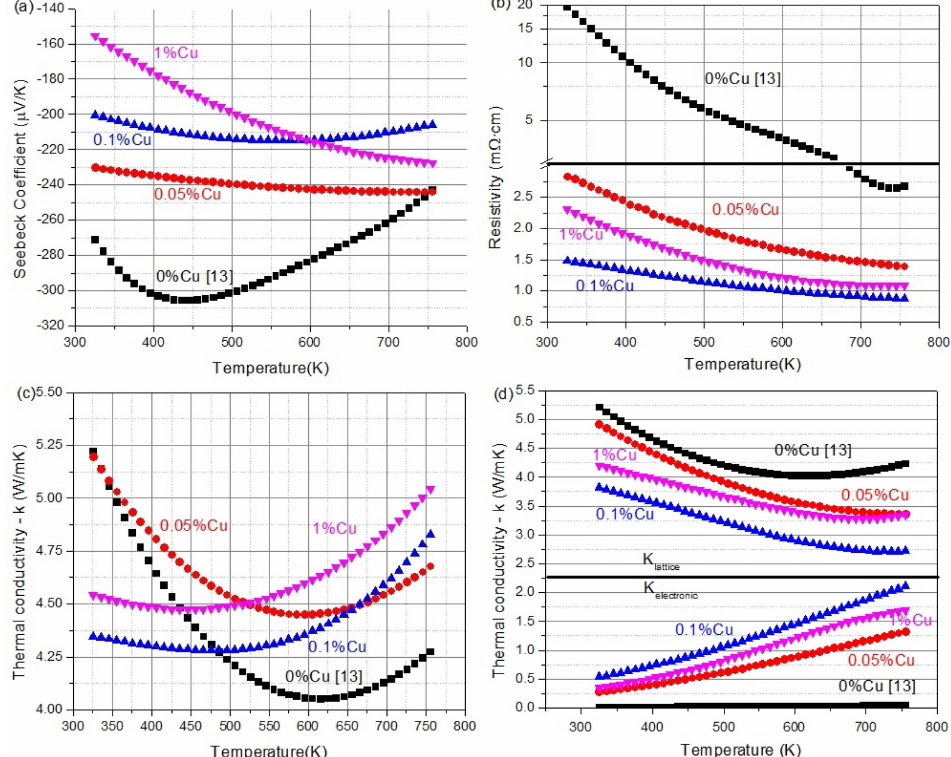
Figure 5. The transport properties of the currently investigated 3 compositions with 0.05%, 0.1%, and 1% Cu doping with the 0% Cu sample taken from K. Chen et al. [13] for reference. ( a ) the Seebeck coefficient, ( b ) resistivity, ( c ) thermal conductivity, and ( d ) separating into electronic and lattice thermal